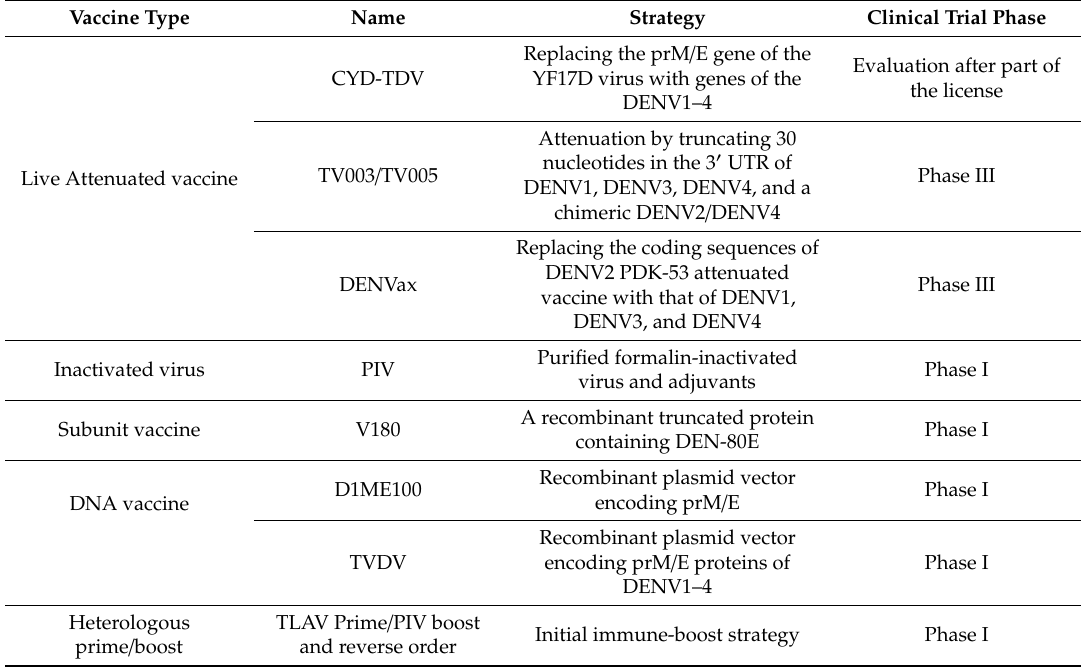
Table 1. Dengue vaccine candidates in use or in clinical